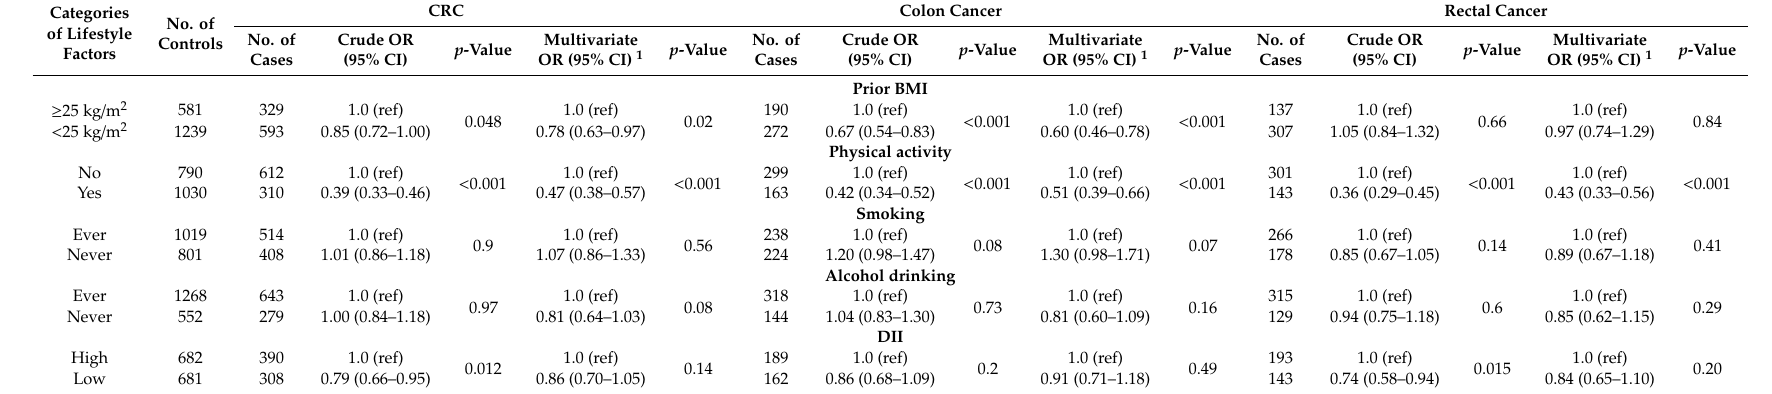
Table 3. Associations between modifiable health-related factors and CRC risk by anatomical